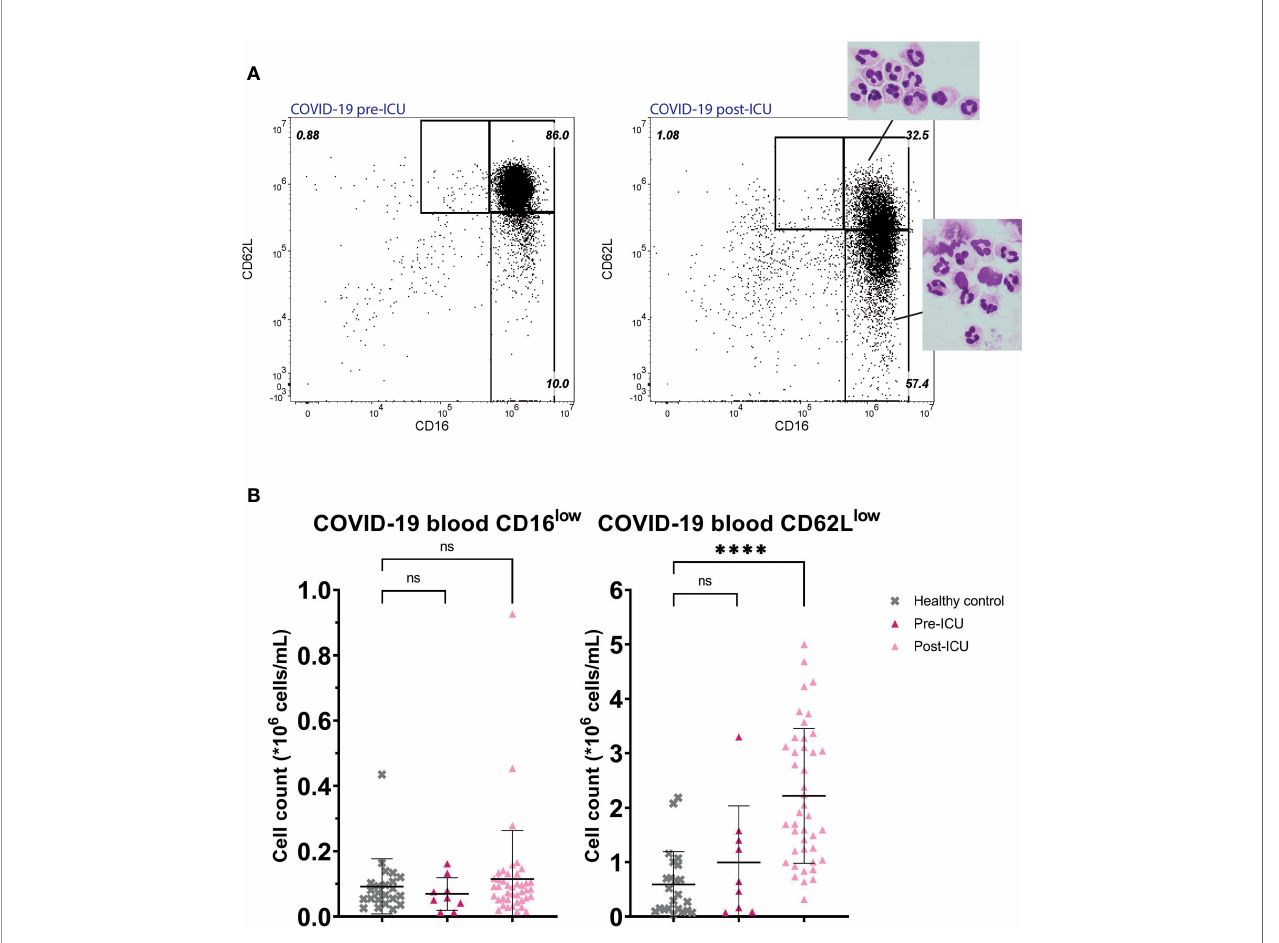
FIGURE 4 | COVID-19 patients pre- and post-ICU. Representative FACS examples of CD16/CD62L plot of blood from a hospitalized COVID-19 patient before admission to the ICU (left panel) and from the same patient post-ICU with corresponding nuclear morphology of the subsets (right panel) (A) . Cell counts of CD16 low neutrophils (left panel) and CD62L low neutrophils (right panel) in healthy control (HC) blood (n=23) and in blood from COVID-19 patients pre-ICU (n=9) and post-ICU (n=41) (B) . Lines are means with SD. A one-way ANOVA analysis (unpaired) with a post-hoc Dunnett ’ s multiple comparisons test was used to test signi fi cance. Signi fi cance is displayed in graphs as ns, not signi fi cant, P****